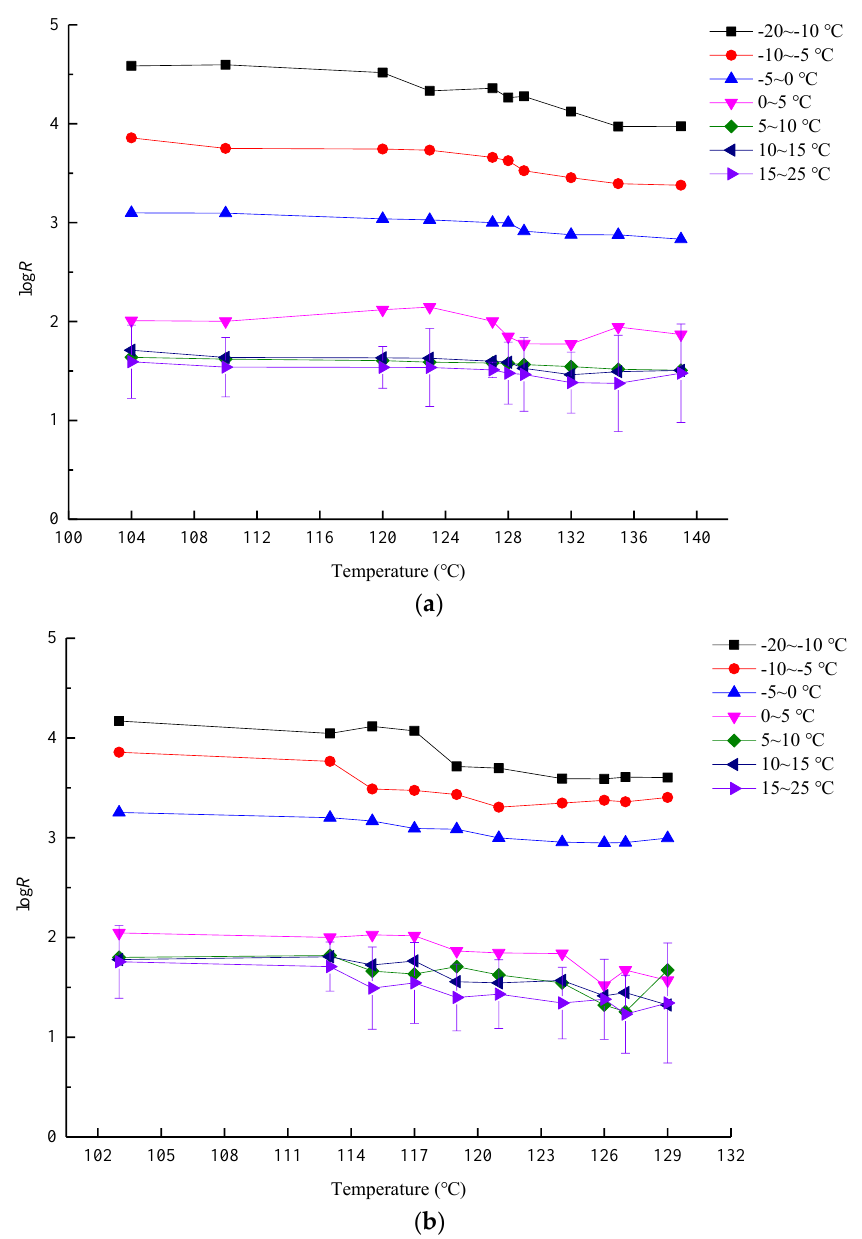
Figure 6. Effect of moisture content on the logarithmic value of mean resistance in the cross-section of living trees ( Populus simonii ) under different temperatures. ( a ) Sound trees; ( b ) Decayed trees.